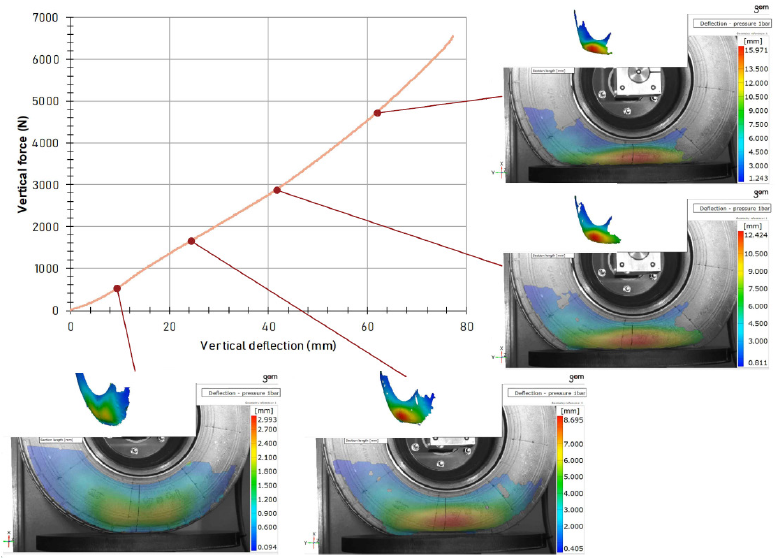
Figure 6. Example results of 3D tyre deformation measurement for the operating pressure p 1 = 1.0 bar